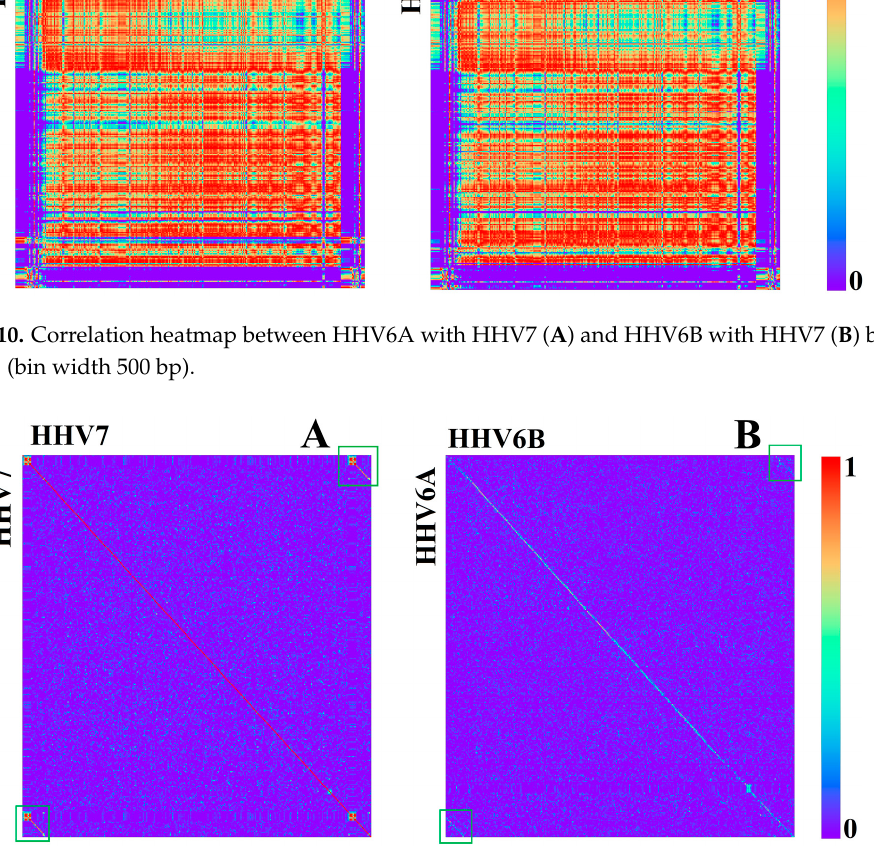
Figure 11. Correlation heatmap between HHV7 with itself ( A ) and HHV6A with HHV6B ( B ) based on relative k = 4 (bin width 500 bp). Beginning and ending regions are highlighted with green boxes.